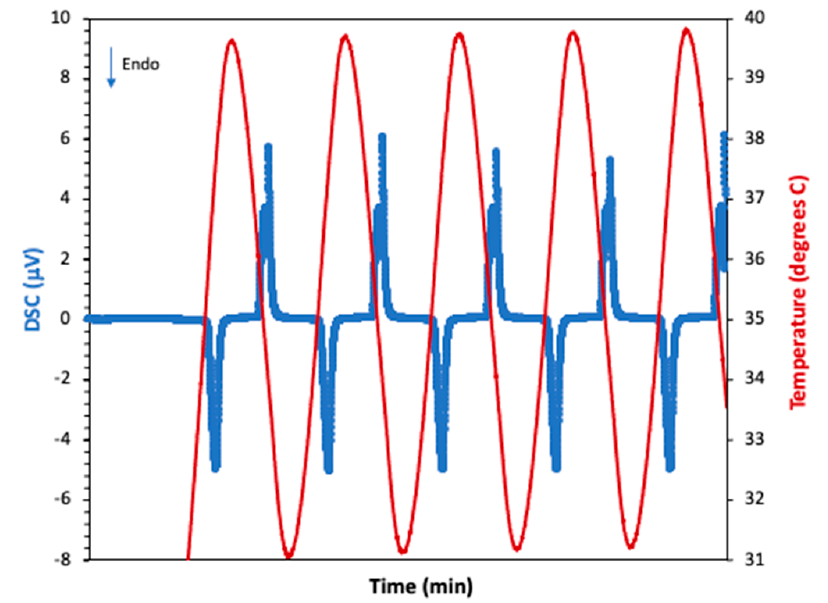
Figure 8. DSC analysis of eicosane showing the melting and solidification processes as the sample was cycled. The blue line represents the changes in the DSC signal (associated with the heat flow) and the red, the temperature.